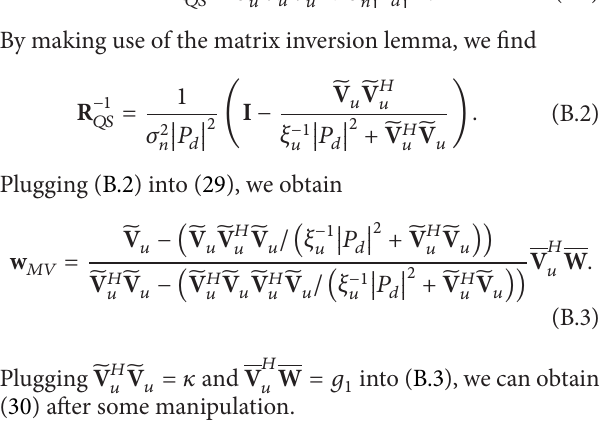
quaternion model of linear symmetric array with 2𝑀 two- component EM vector sensors. Since the QSWL GSC consists of two-stage beamformers, it has more information than the complex “long vector” beamformer. The increase of information results in the improvement of the beamformer’s performance. By designing the weight vectors of two-stage beamformers, the interference is completely canceled in the output of QSWL GSC and the desired signal is not distorted. Simulation results reveal that the proposed QSWL GSC has the better performance in small angular separation and the robustness to DOA